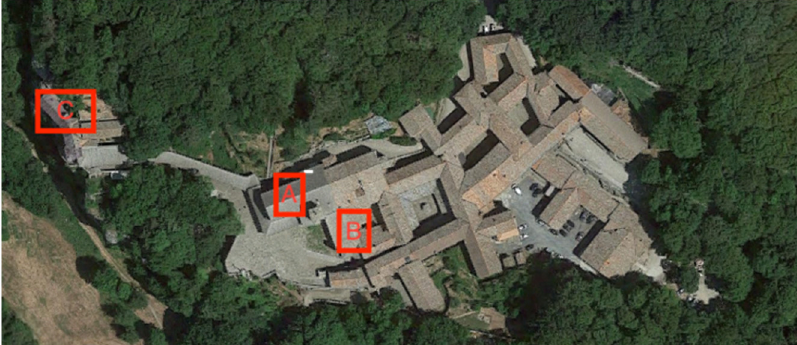
Figure 1. Aerial view of La Verna monastery. ( A ) Chiesa Maggiore; ( B ) Santa Maria degli Angeli; ( C ) Chapel of the Stigmata.